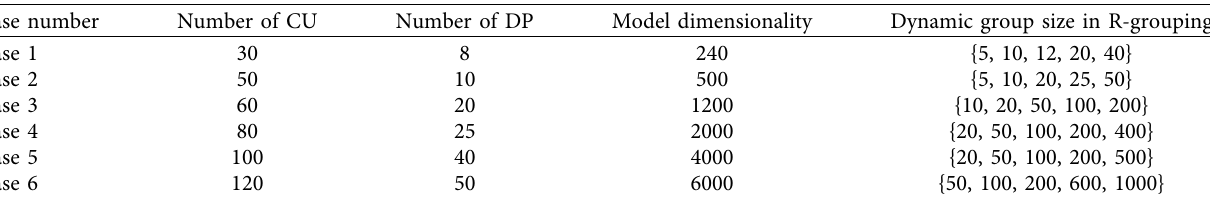
Table 2: Parameter settings of resource allocation